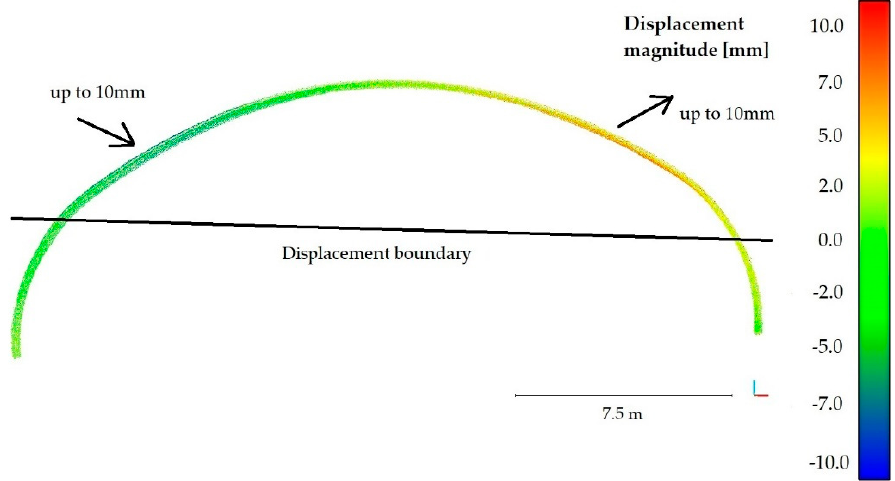
Figure 19. Displacements of the unloaded steel shell 4-4 section one year after the final acceptance and inspection tests.